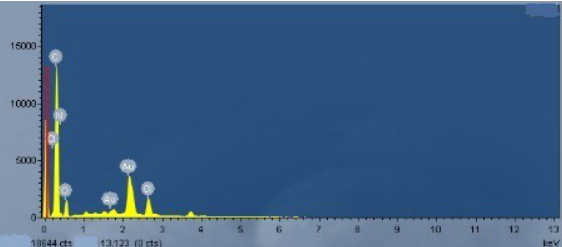
Figure 9. EDS results of one microdomain containing Au nanoparticles of Au/PANi nanocomposites functionalized with beta-cyclodextrin.